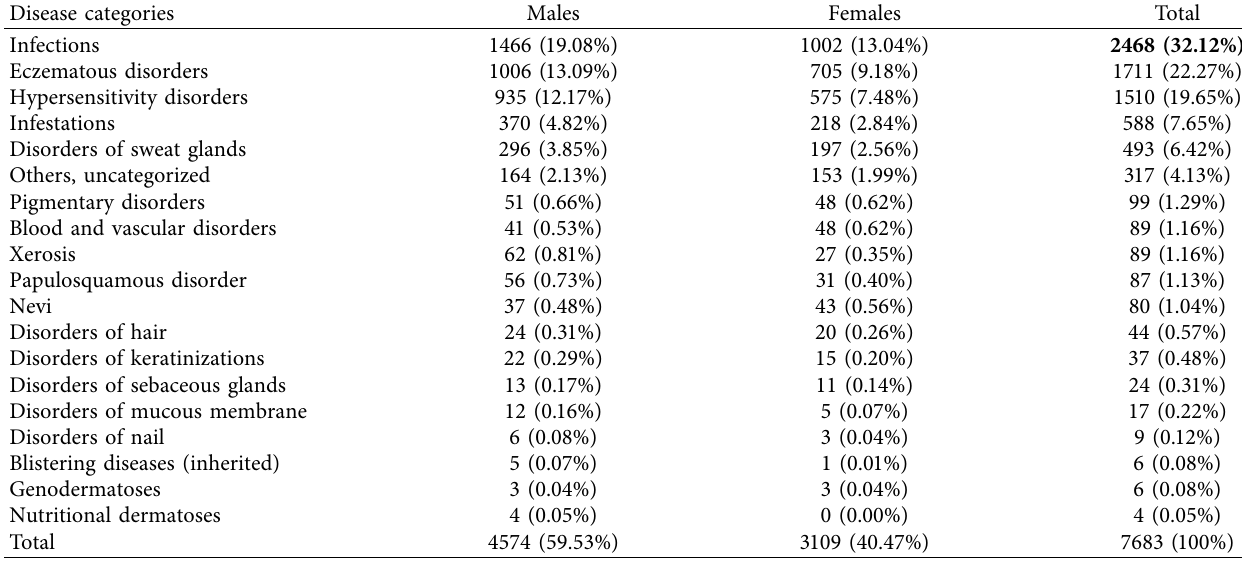
Table 1: Distribution of diseases according to different categories in a one year period.